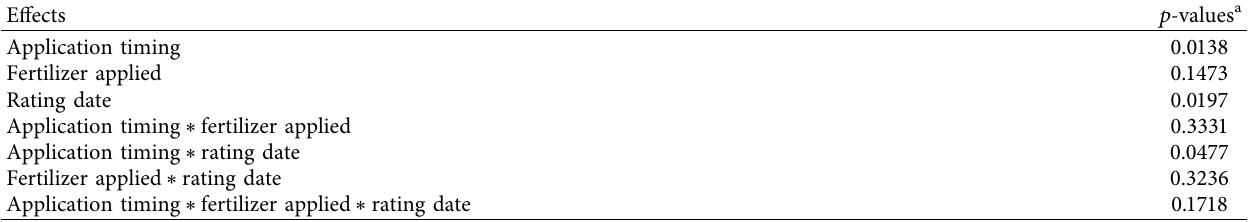
Table 4: Effects of application timing, fertilizer applied, and rating date to soybean injury of fertilizer experiment conducted in Fayetteville, AR, in 2019 and